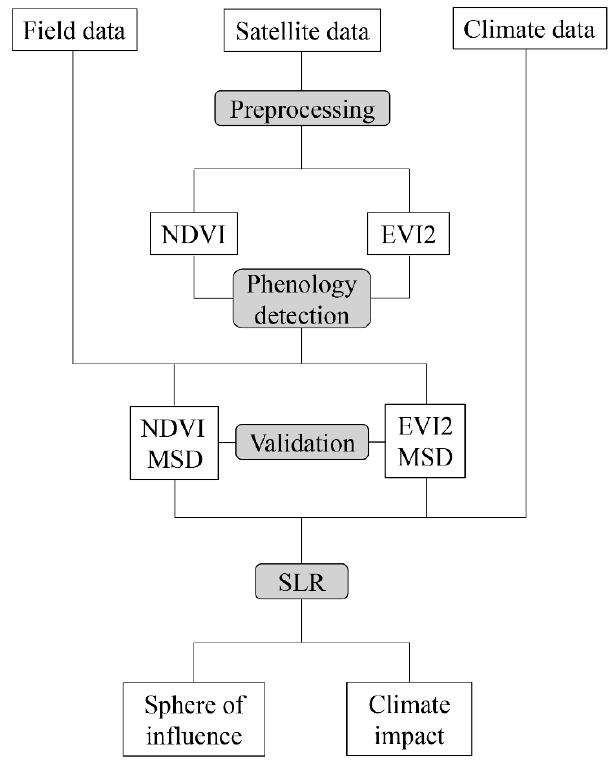
Figure 1. Flow diagram of data processing and analyses. MSD denotes the middle senescence date. SLR denotes the stepwise linear regression.